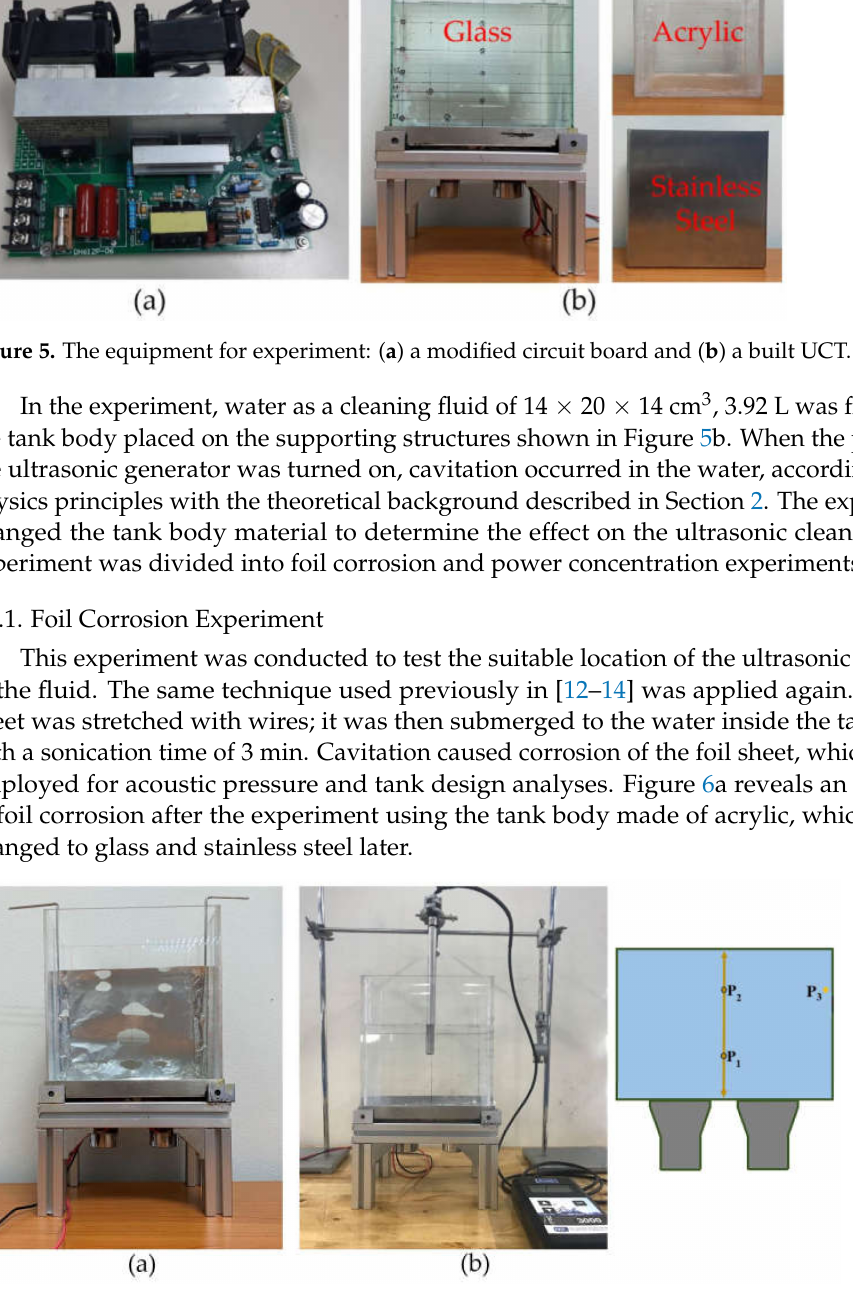
Figure 6. The example of experiment setup: ( a ) a foil corrosion and ( b ) a power concentration and sampling